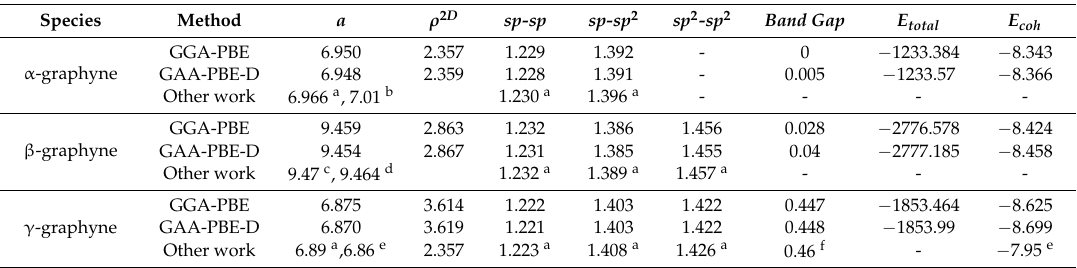
Table 1. Graphyne ( α , β , γ ) model parameters: lattice constants a , b (Å), density ρ 2 D (g · cm − 2 ), bond type and bond length (Å), band gap (eV), total energy E total (eV), binding energy E coh (eV). Species α